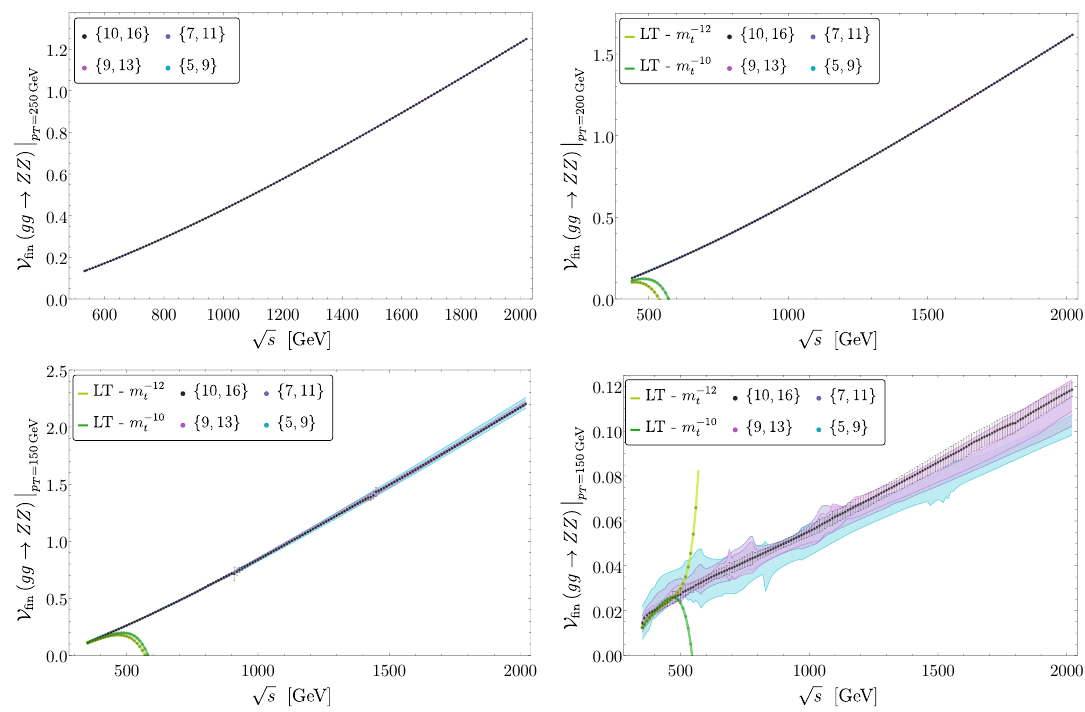
Figure 8 . as a function of p s for p T values of 250, 200 and 150 GeV. The curves denoted V (cid:12)n \LT" show the large- m t expansion to orders m (cid:0) 10 light quark contributions introduced in eq. (5.1).